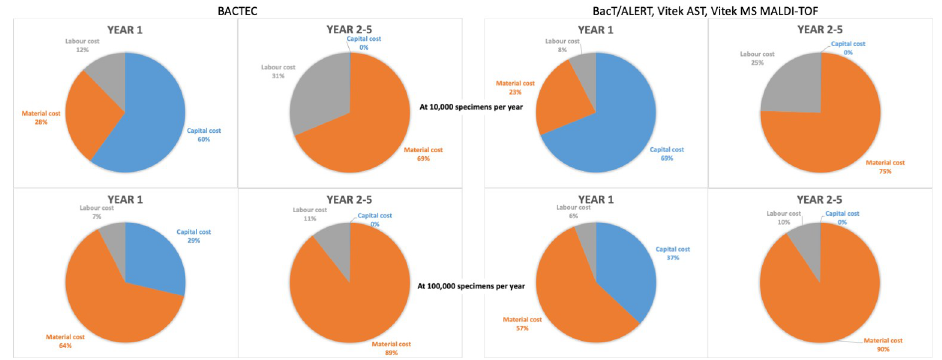
Fig 2. Contribution of the cost of setting up a microbiology laboratory using the BACTEC (lowest cost) and using the BacT/Alert, Vitek AST, Vitek MS MALDI-TOF (highest cost) at two scales (10,000 specimens per year and 100,000 specimens per year) from top down approach. Capital costs include equipment purchasing, labour costs include staff wages and material costs include consumables, reagents and equipment